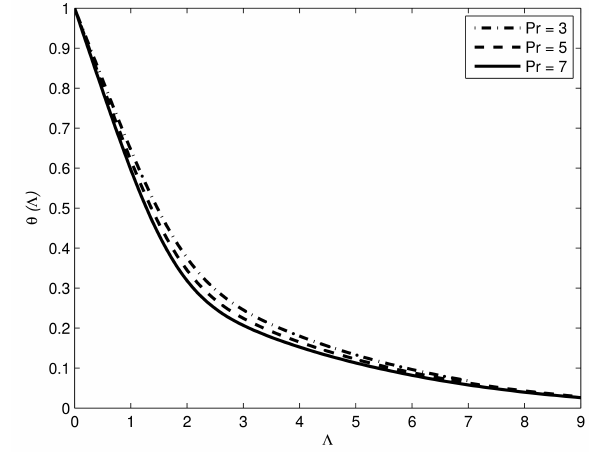
Figure 20: Effect of Pr on θ ( Λ ) keeping ζ = 0.5 , η = 0.2 , C 1 = C 2 = C 3 = 400 , Br = 1 , Re = 40